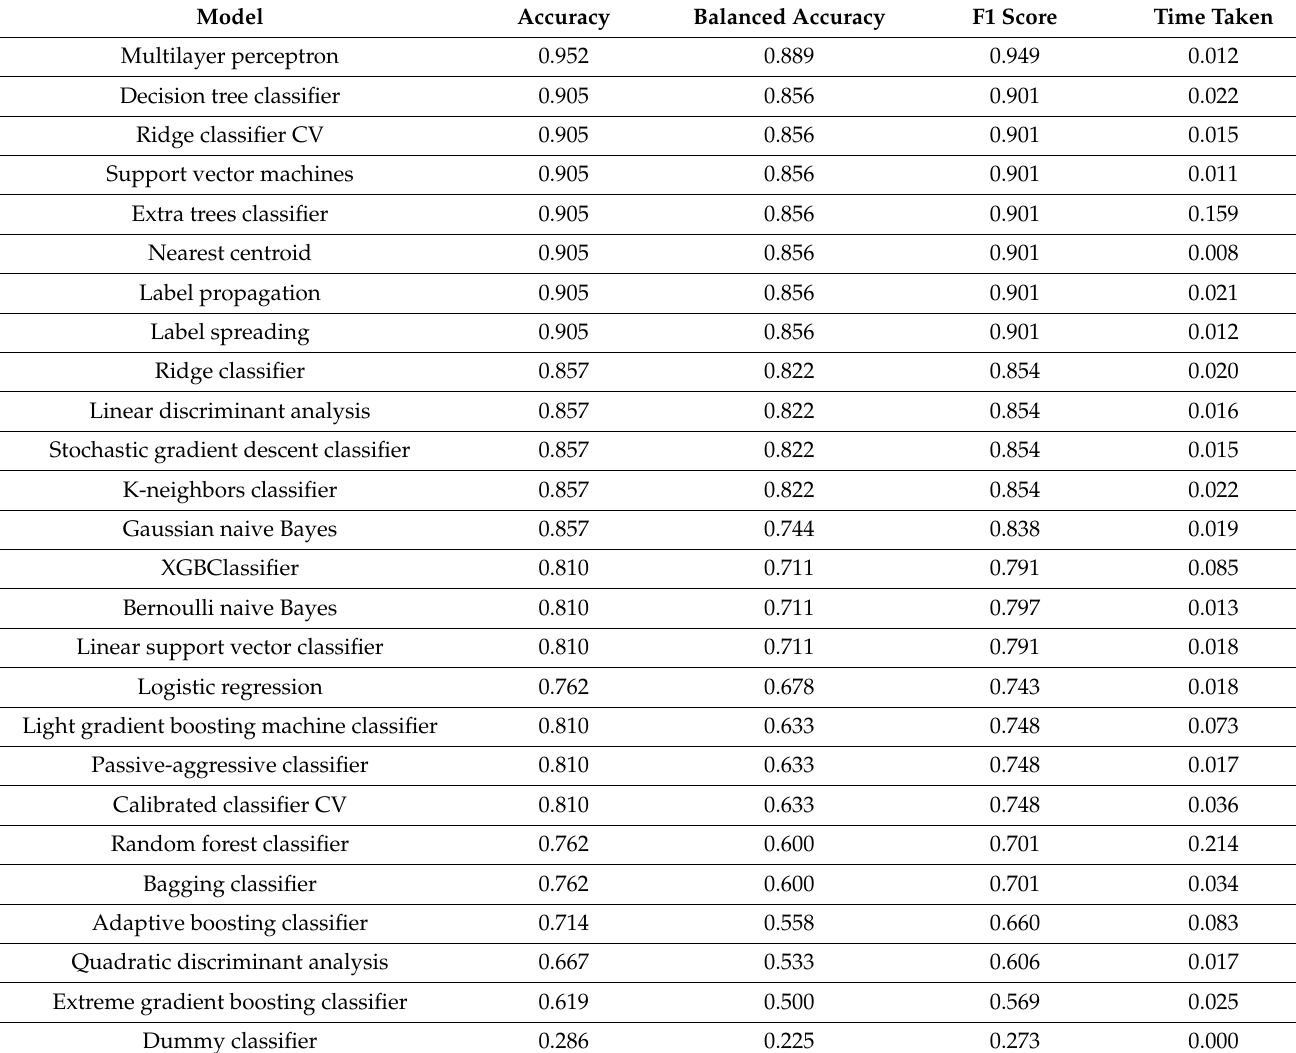
Table 2. Statistical parameters obtained from different linear and nonlinear machine learning algo- rithms in classifying ‘low’, ‘medium’, and ‘high’ Verticillium dahliae ID classes with several physic- ochemical parameters in a study where the effect of previous cropping history was assessed on densities of V. dahliae in olive-growing areas of the Iberian